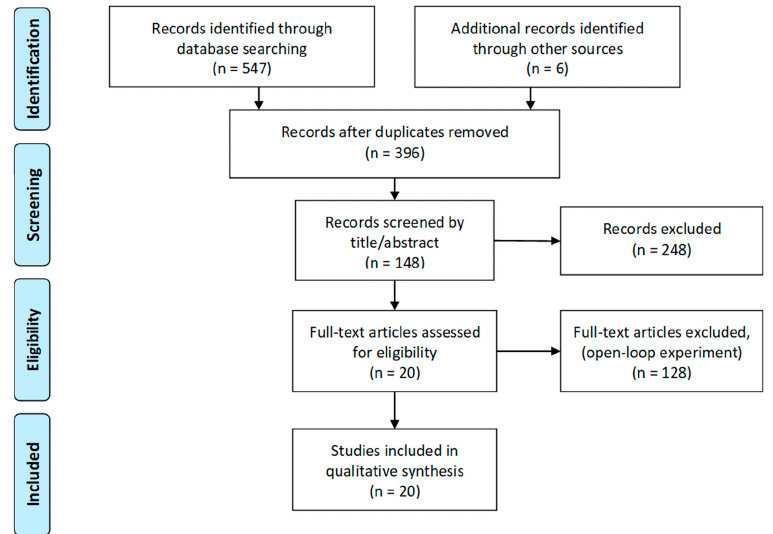
Figure 1. Preferred Reporting Items for Systematic reviews and Meta-Analysis (PRISMA) flow diagram of closed-loop feedback sleep studies.